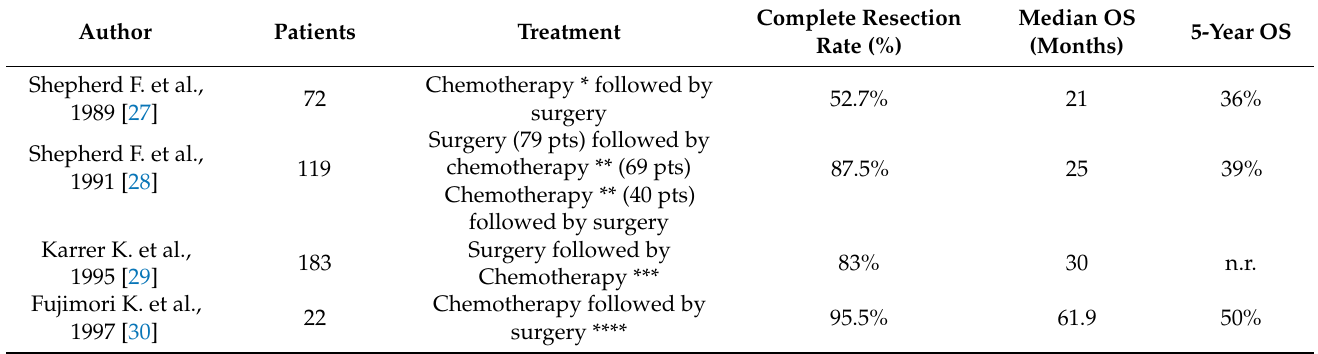
Table 2. Prospective non-randomized trials evaluating the role of